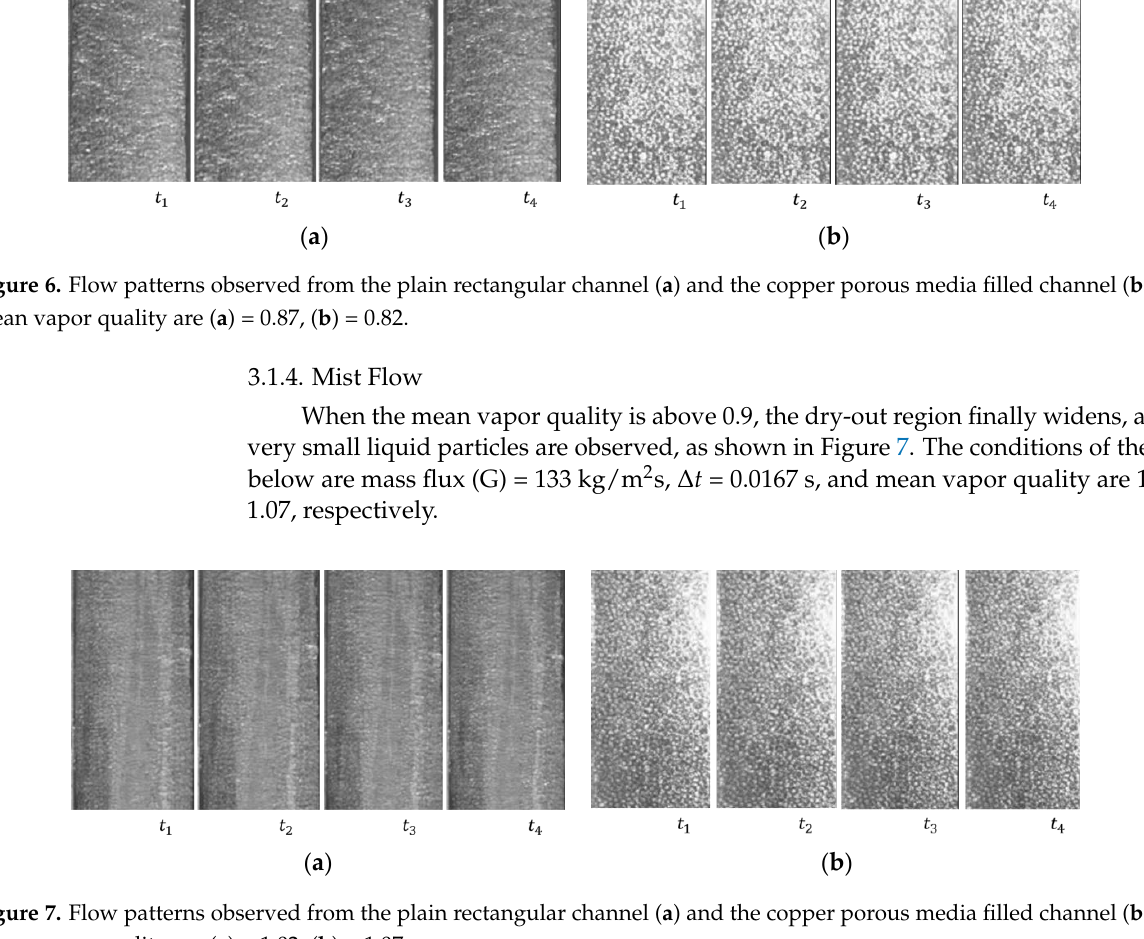
Figure 5. Flow patterns observed from the plain rectangular channel ( a ) and the copper porous media filled channel ( b ) at mean vapor quality are ( a ) = 0.48, ( b ) = 0.48.